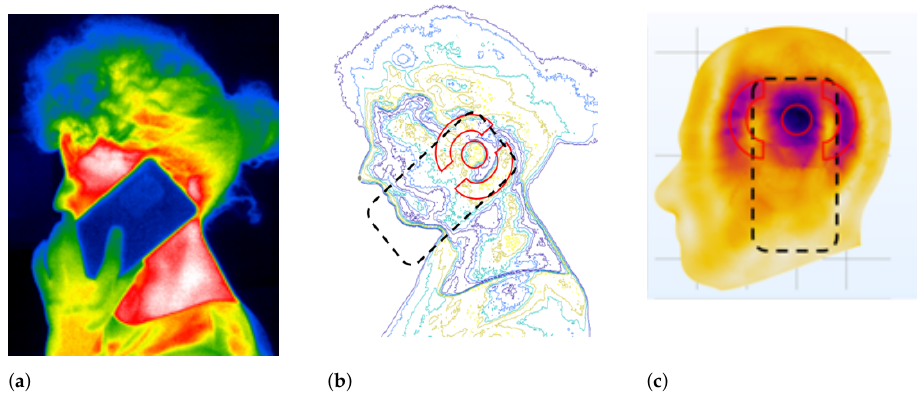
Figure 5. ( a ) Visualization of thermal effects in a human head before use of a GSM device; ( b ) visualization of thermal effects in a human head during use of a GSM device; and ( c ) visu- alization of thermal effects in a human head after use of a GSM